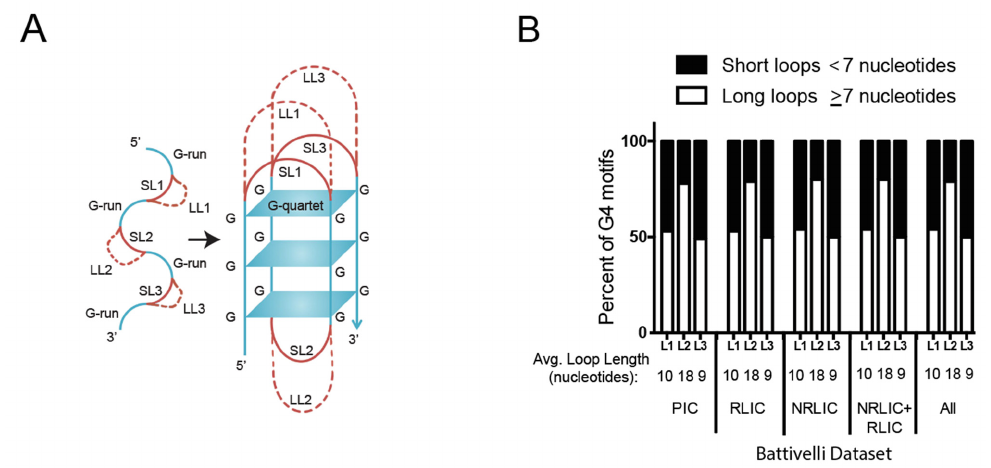
Figure 3. Integration in or near G4 motifs favors G4 structures with long-loops. ( A ), Schematic de- picting a G4 motif (left) and G4 structure (right) consisting of four adjacent runs of two or more guanines, with three loop regions of nucleotide subsequences (L1, L2, and L3) connecting the G- runs. Loops containing <7 nucleotides are considered short-loop (SL) G4s (solid red line), whereas ≥ 7 are considered long-loop (LL) G4s (dashed red line). ( B ), G4 motif sequences located within 500 bp of an integration site were isolated from the Battivelli datasets and the loop-lengths were calcu- lated. The percentage of G4 motifs in each dataset classified as short-loops or long-loops were com- pared in the bar graphs. The average loop lengths for each of the three loops were calculated and are shown below each bar graph.